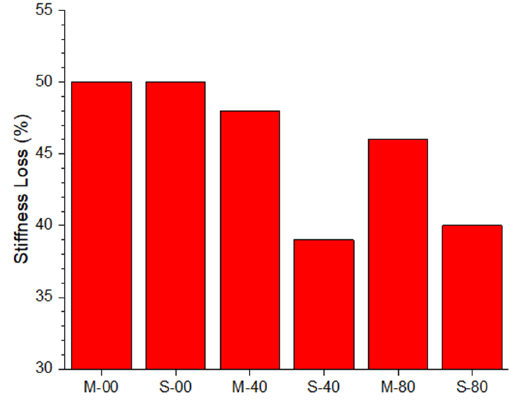
Figure 7. Stiffness loss of rigid pavement specimens tested in 4PB fatigue tests.